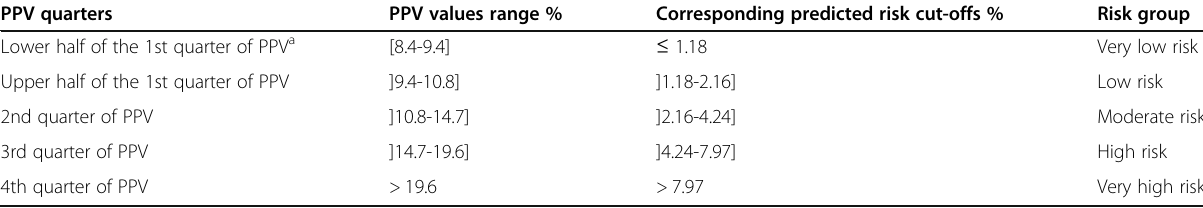
Table 1 Risk groups cut-offs after regulating IDIOM model based on the quartiles of